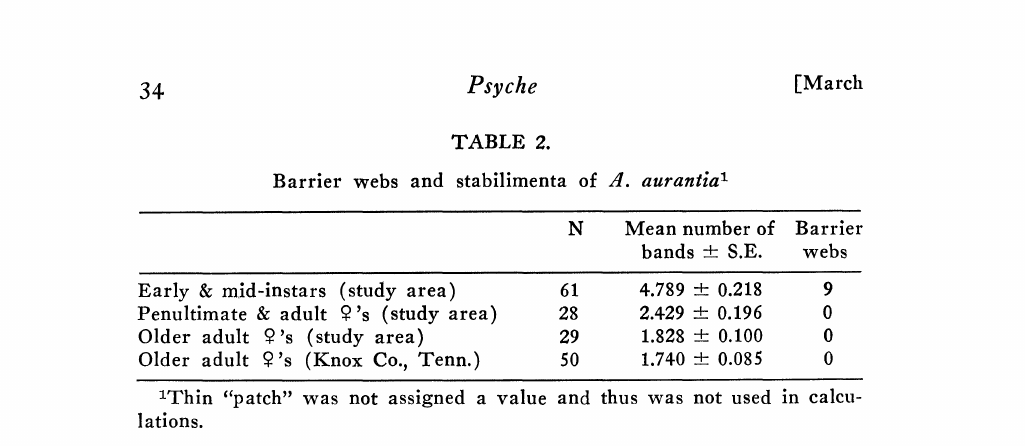
Mean number of Barrier bands +